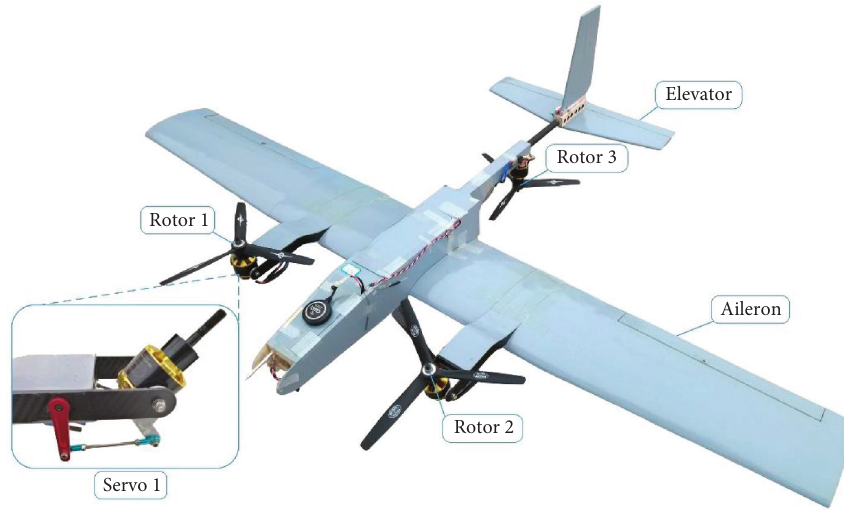
Figure 1: Airframe and actuators of the tilt trirotor